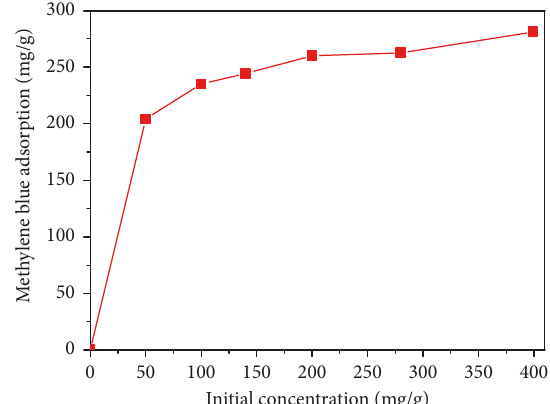
Figure 7: Effect of initial methylene blue concentration (contact